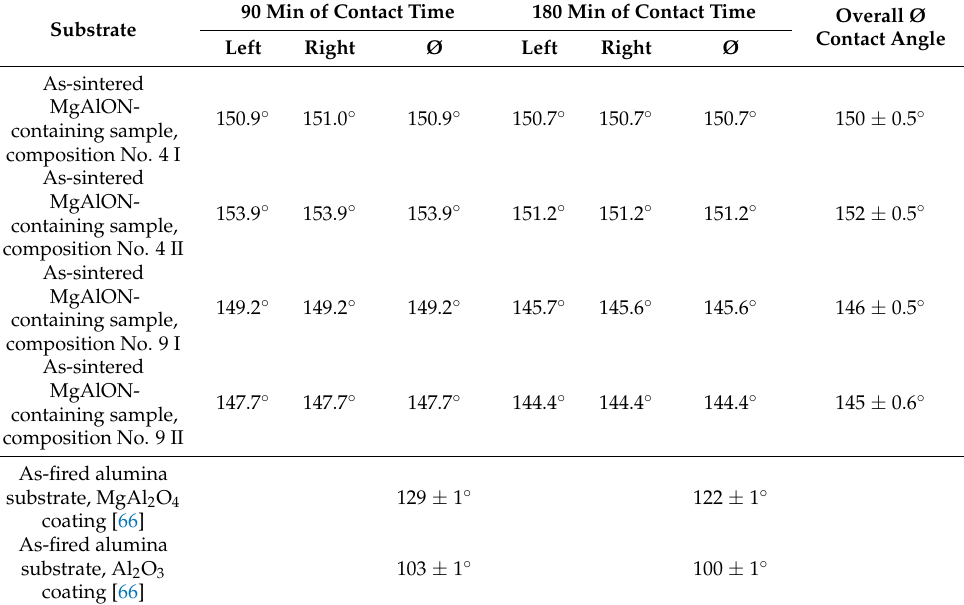
Table 8. Measured contact angle θ at 950 ◦ C for MgAlON- and Al 2 O 3 -/MgAl 2 O 4 -containing [66]